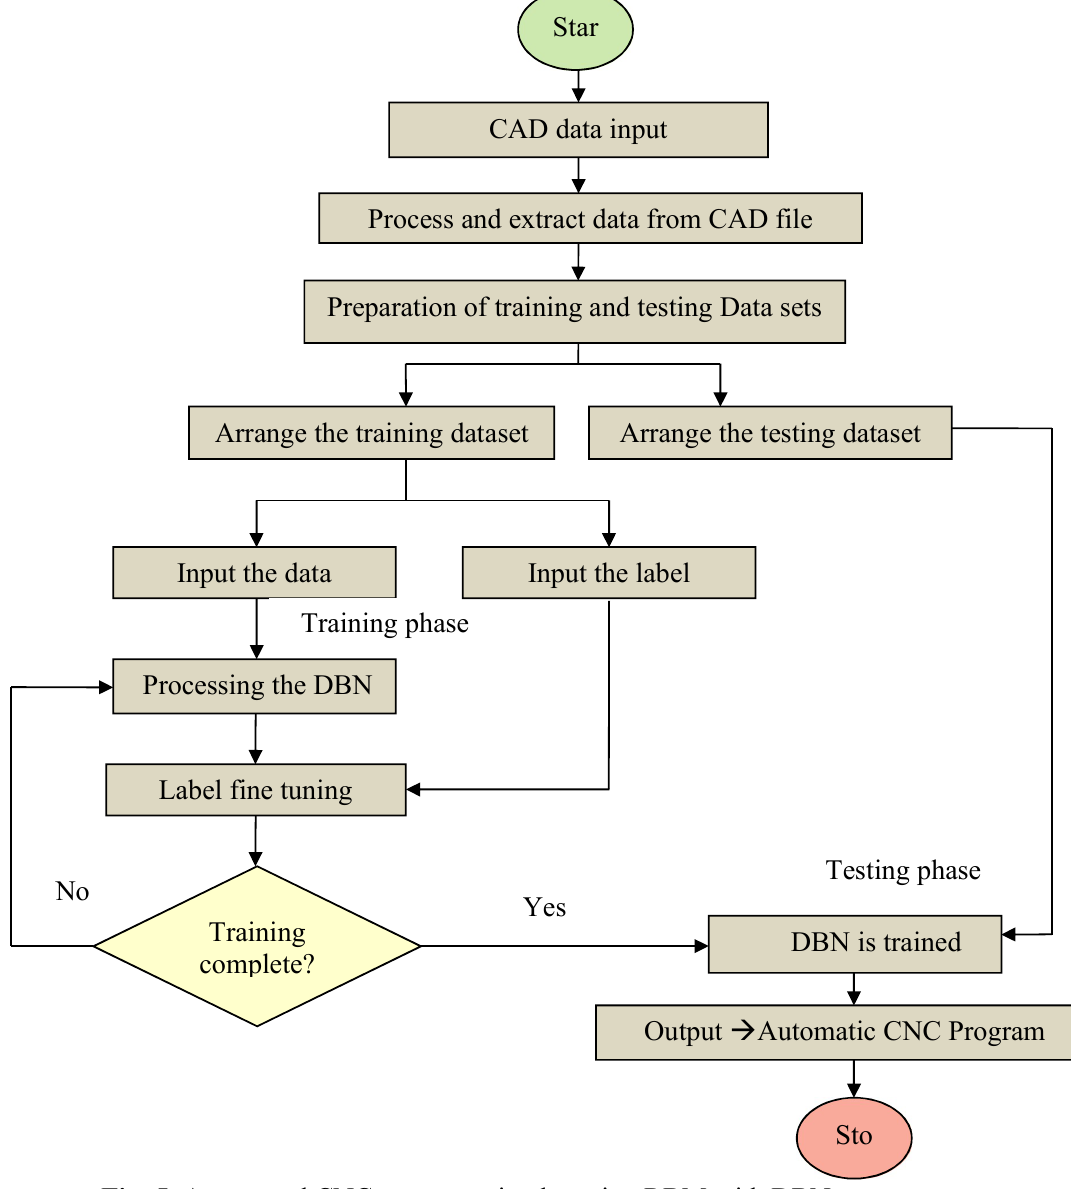
Fig. 5. Automated CNC programming by using RBM with